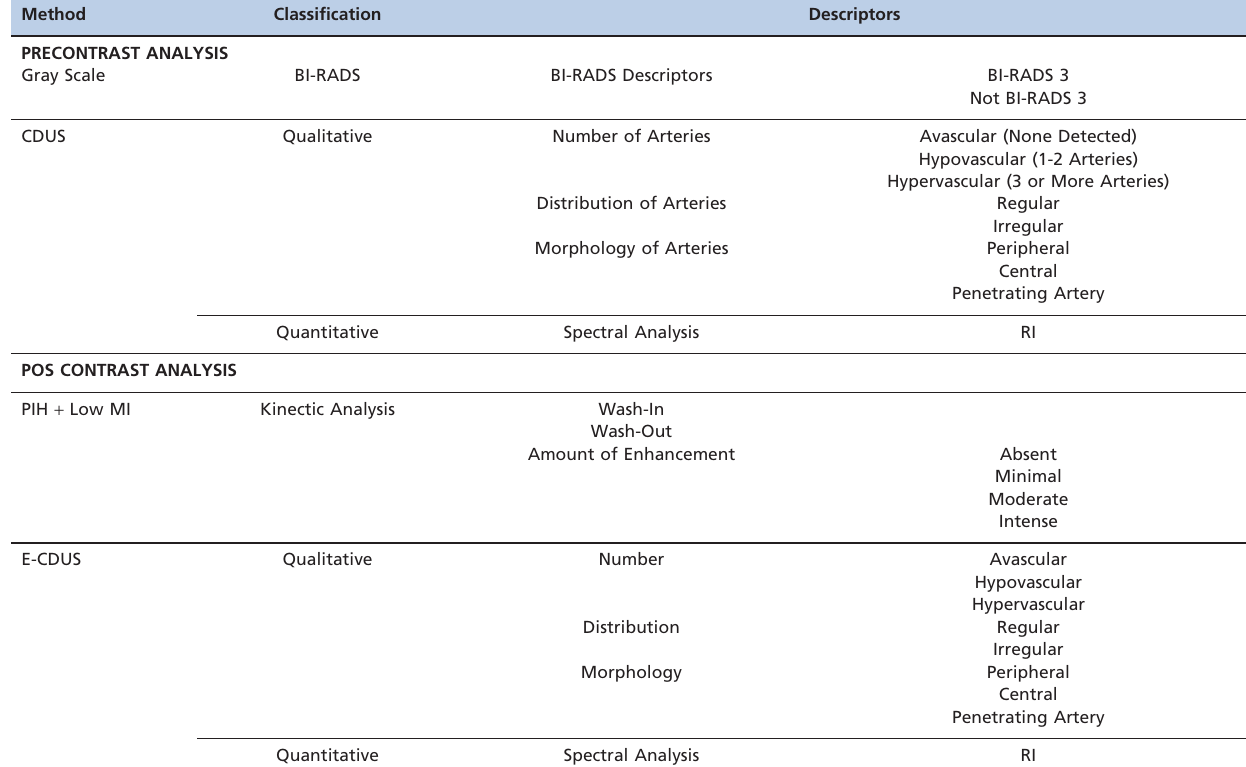
Table 1 - Methods and descriptors used to classify lesions.